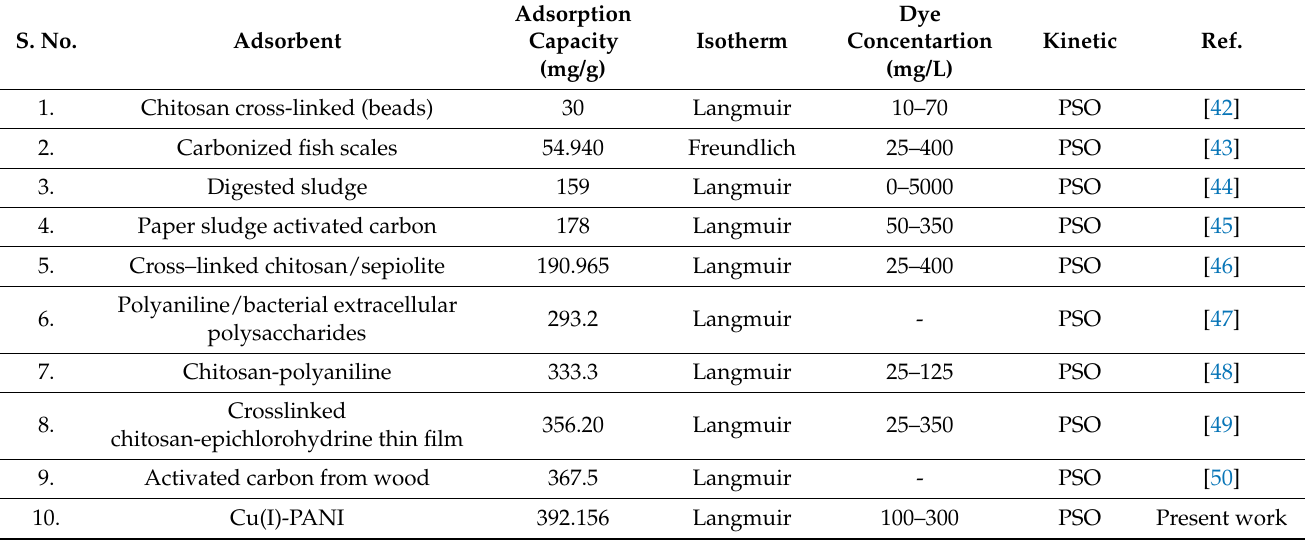
Table 4. Comparison of maxima adsorption capacities for RO16 taken